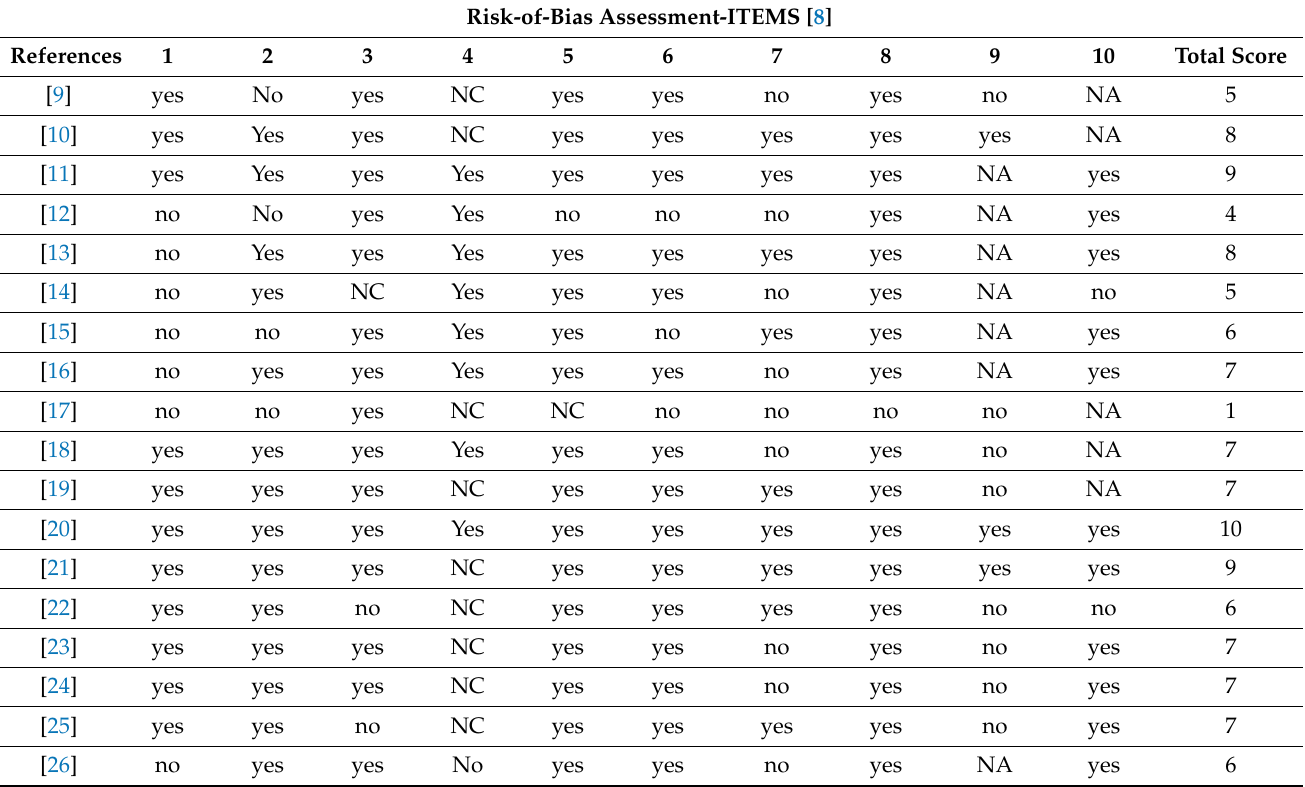
Table 3. Risk-of-bias assessment based on the 10-items scale by Munn et al., 2020 [8]. Abbreviations: NC = Not Clear; NA = Not